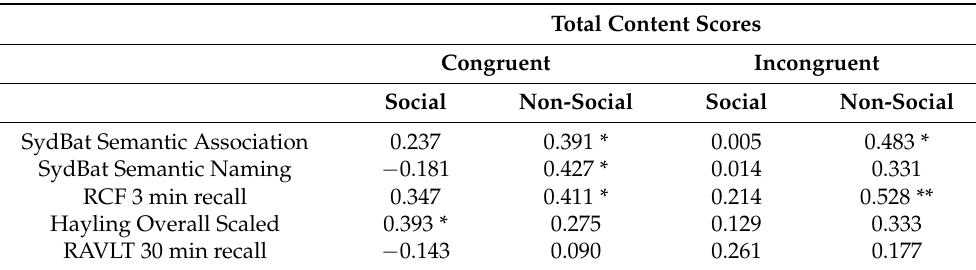
Table 4. Pearson correlation coefficients exploring associations between scene construction perfor- mance and cognitive variables in AD and bvFTD groups combined ( n = 23). Total Content Scores Congruent Incongruent Social Non-Social